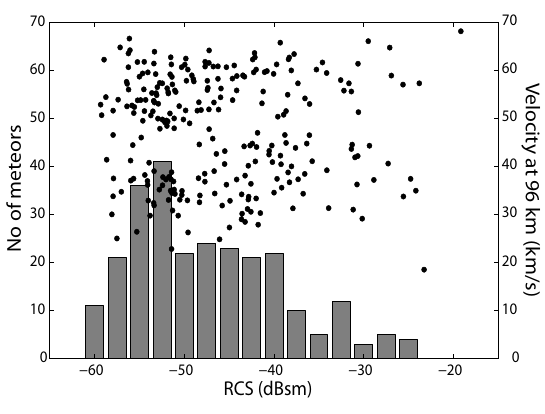
Fig. 10. Distribution of estimated atmospheric entry masses for the detected meteoroids.